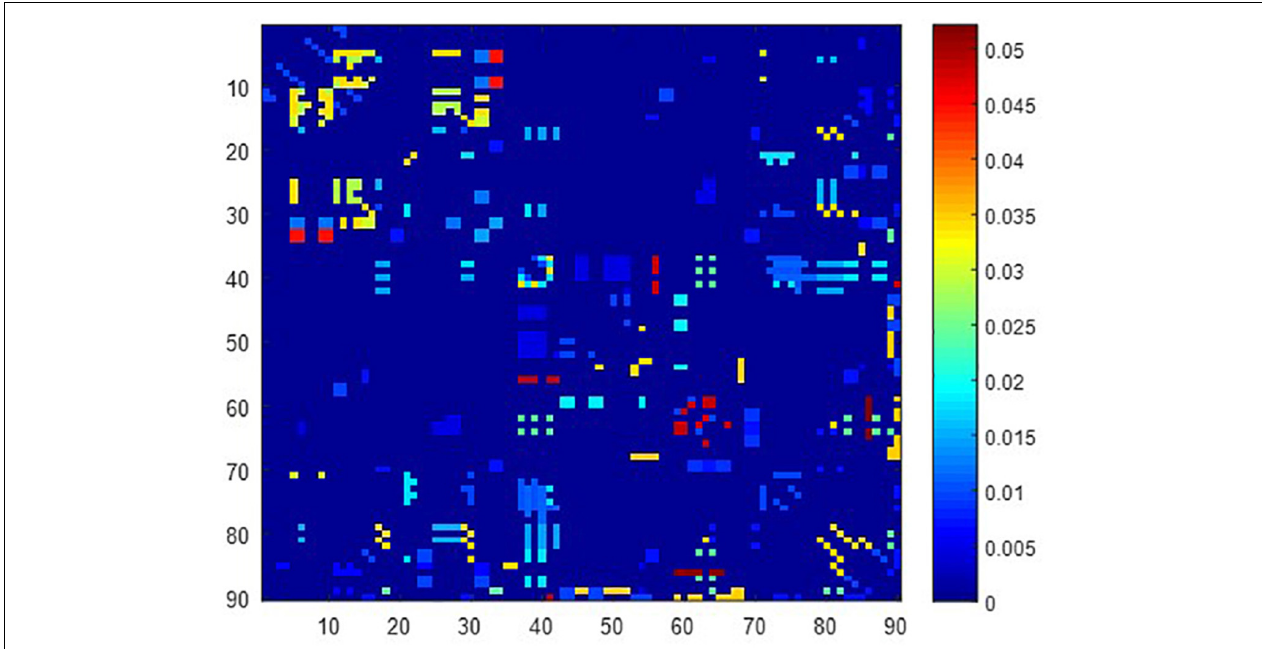
FIGURE 7 | Visualized ROIs selected from high-order FC networks, the brighter the color is, the more important a cluster is.